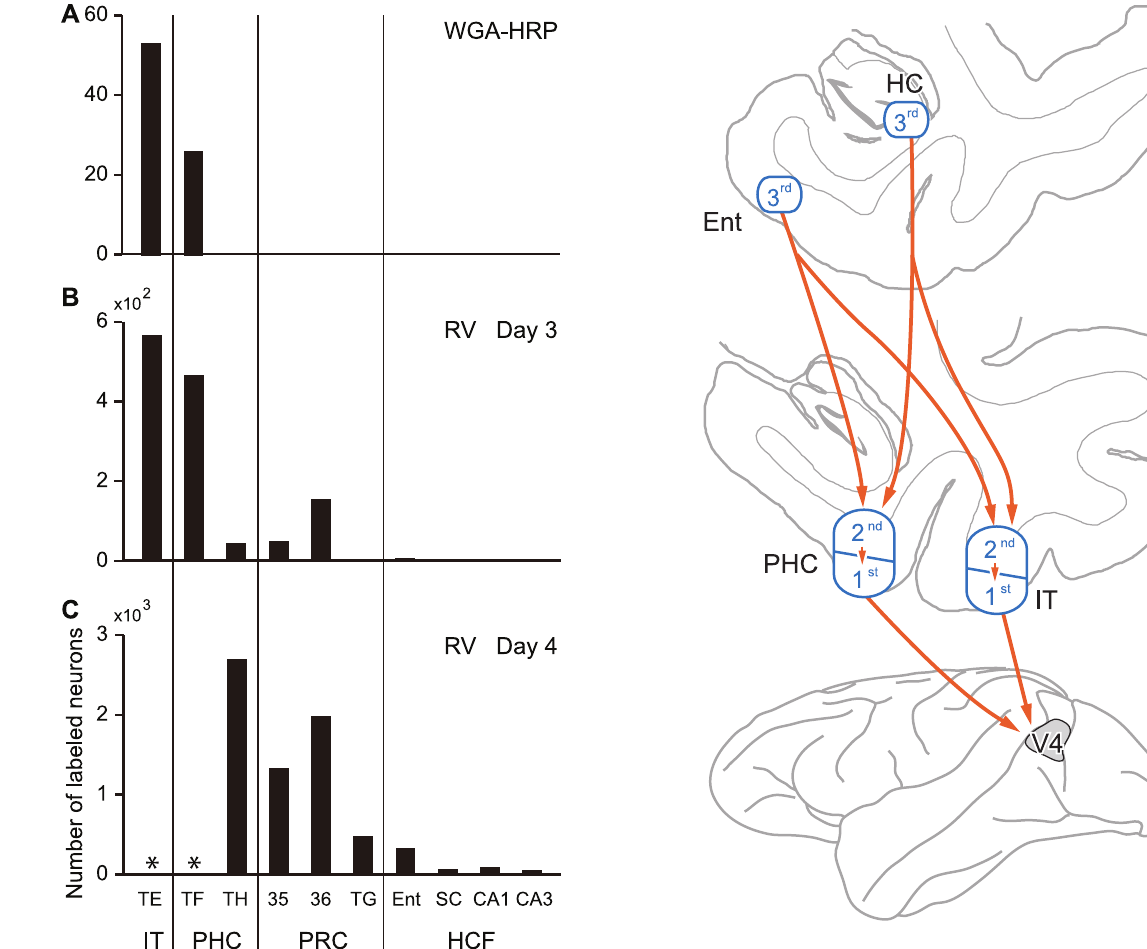
Figure 4. Summary diagram showing possible multisynaptic pathways from the MTL to V4. Our results indicate that the entorhinal cortex (Ent) provides trisynaptic input to V4 via either the parahippocampal cortex (PHC) or the inferotemporal cortex (IT), while the hippocampus (HC) does through ‘‘short-cut’’ pathways that bypass the Ent, as denoted by orange arrows. The gray area represents the approximate location whole extent of the rabies injection sites in 4 monkeys used for the present study. For clarity, only presumably major pathways are shown here (see Discussion for details). HC, hippocampus; 1st, first-order neurons; 2nd, second-order neurons; 3rd, third-order neurons.